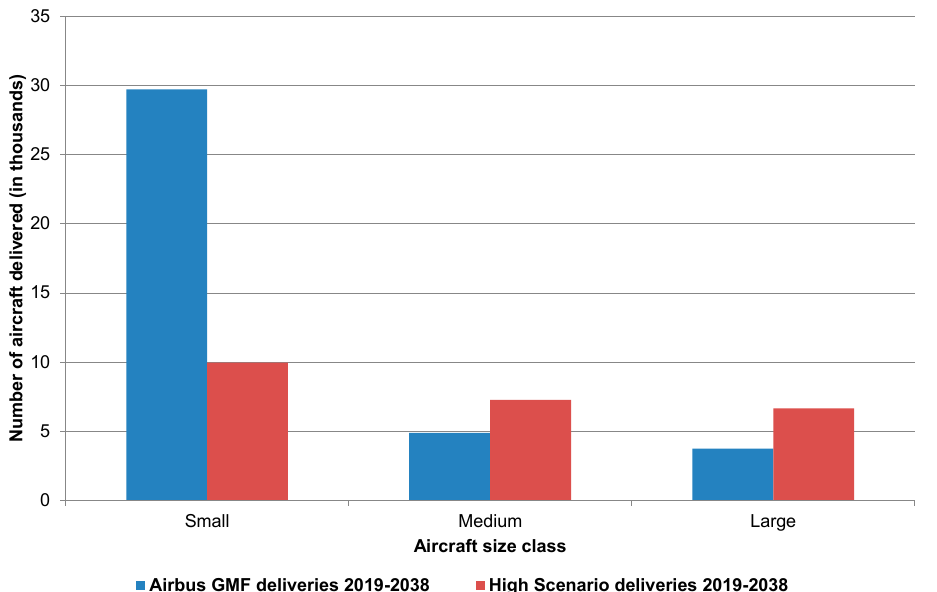
Figure 16. Comparison of the aircraft deliveries forecast of the Airbus GMF and the High Scenario forecast for the time period 2019–2038.